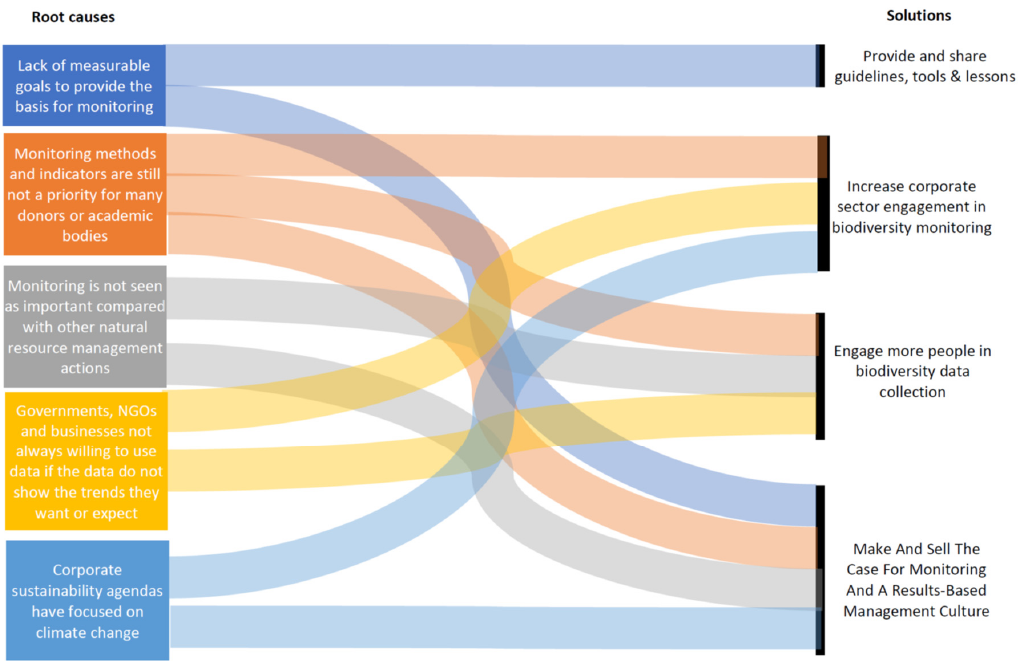
Figure 3. Relationship between the root causes of weak biodiversity monitoring and data use and the solutions to address them. solutions to address